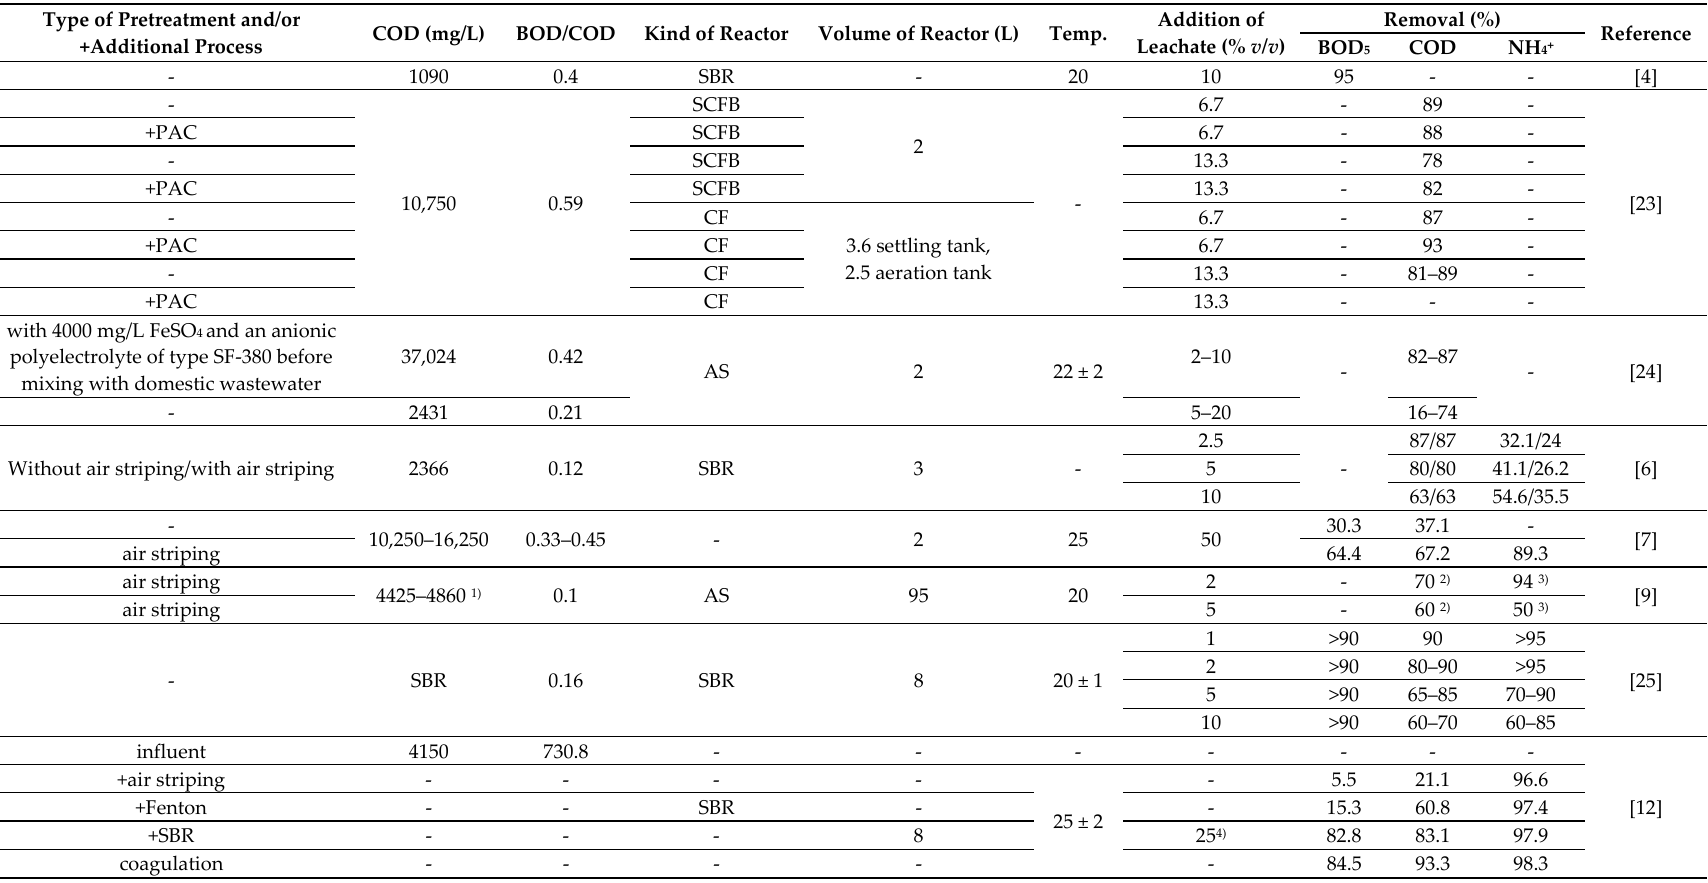
Table A3. Removal efficiency of selected indicators in co-treatment of leachate with